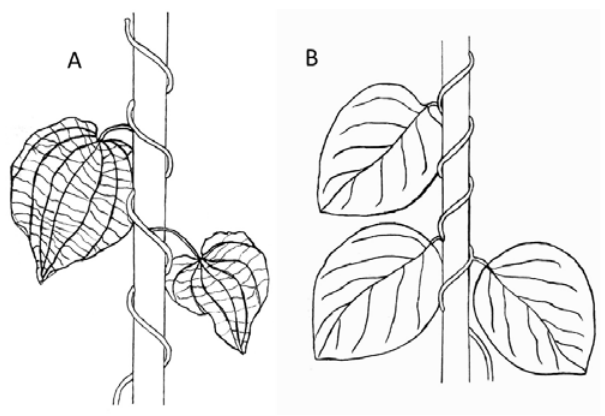
Fig. 5. The two species show their direction of twining. A. Dioscorea bulbifera stem twining in the left-hand direction and B. Basella alba stem in the right-hand direction